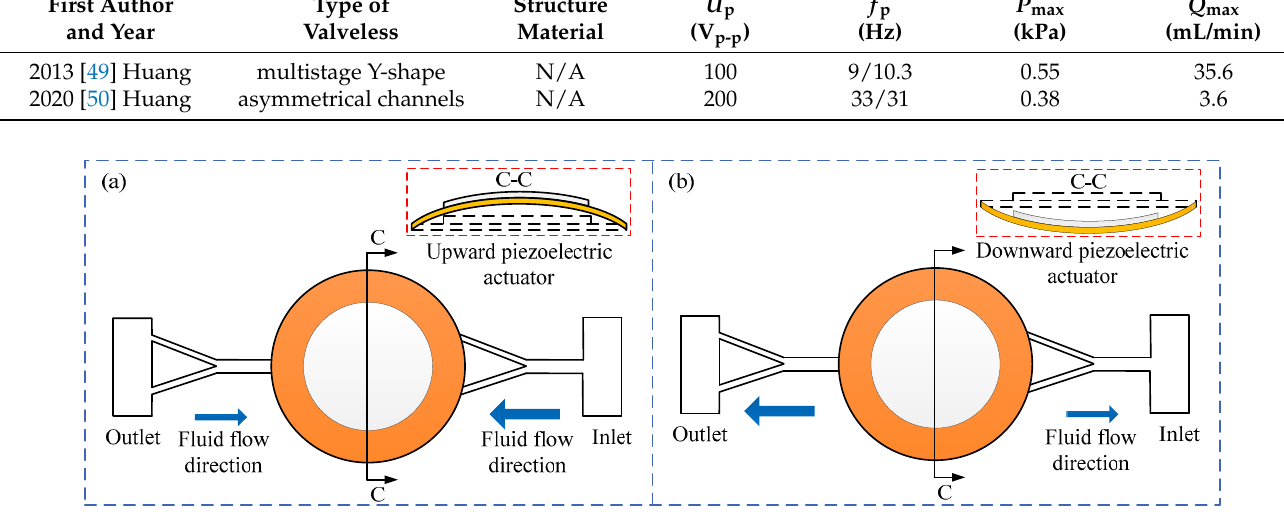
Figure 3. The working processes of valveless piezoelectric pumps with Y-shape tubes. ( a ) Suction process. ( b ) Discharge